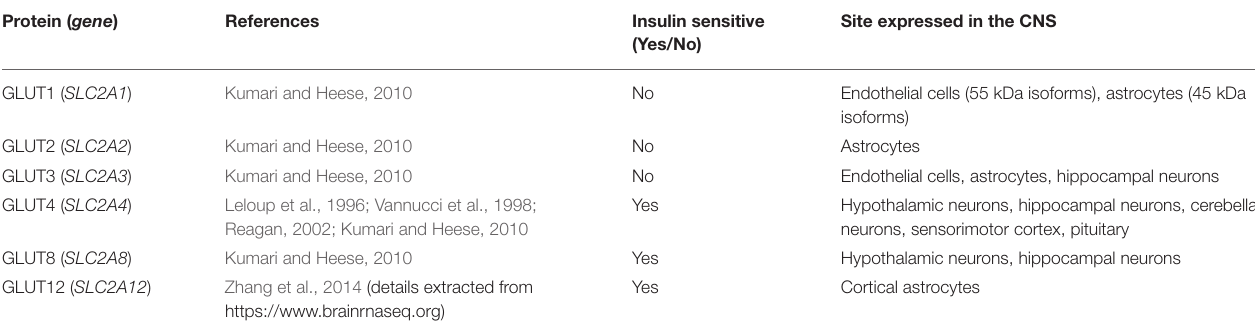
TABLE 1 | GLUTs expressed in the central nervous system. Protein ( gene